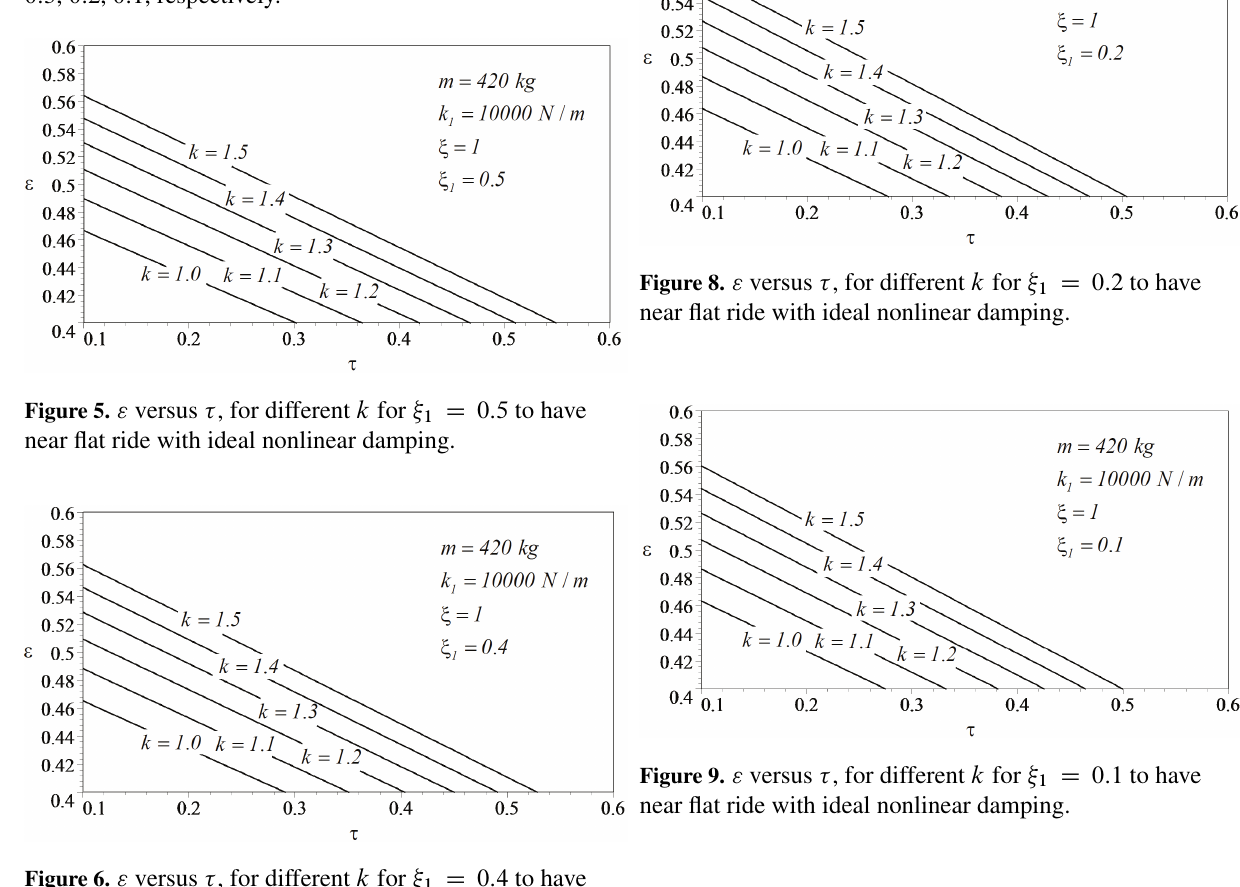
Figure 6. " versus (cid:28) , for different k for (cid:24) 1 D 0:4 to have near flat ride with ideal nonlinear damping.